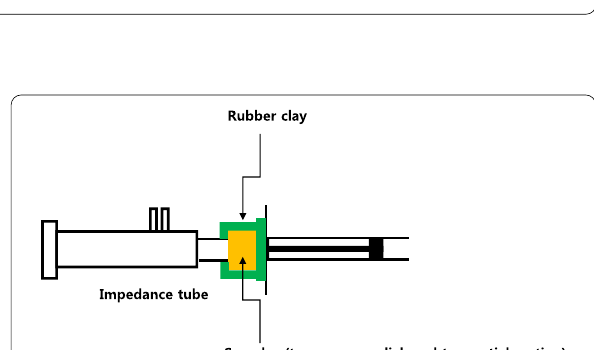
Fig. 1 Photographs of cubic samples before and after microwave treatment